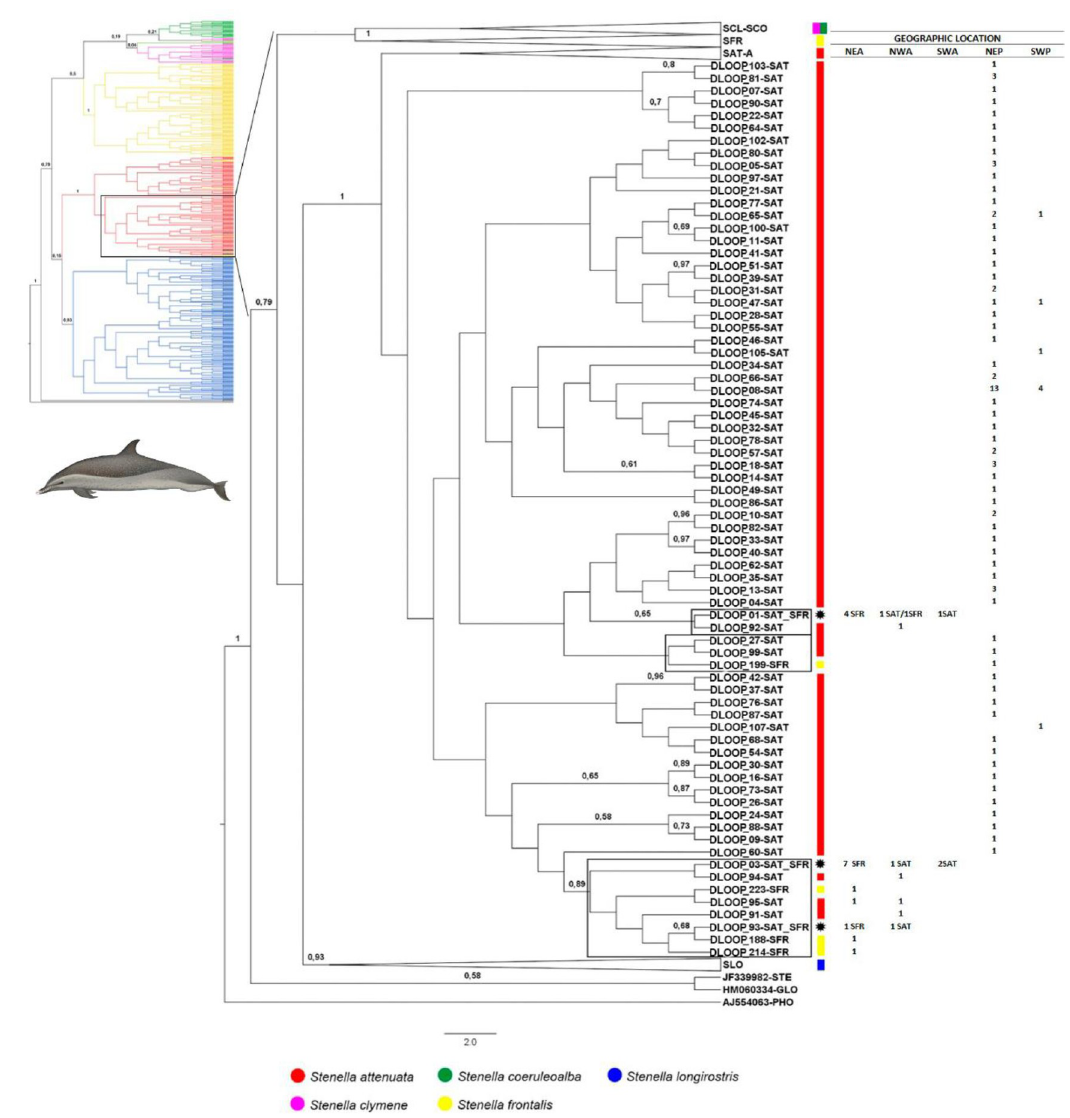
Fig 7. Bayesian cladogram generated in Beast from the Dloop sequences (331bp) highlighting the second clade of Stenella attenuata for ocean basin comparisons. Posterior probability values greater than 0.5 are presented above nodes. Black boxes indicate misplaced haplotypes. Table at right displays the ocean basin location of each haplotype and the number of specimens: NEA (Northeast Atlantic Ocean), NWA (Northwest Atlantic Ocean), SWA (Southwest Atlantic Ocean), NEP (Northeast Pacific Ocean), SWP (Southwest Pacific Ocean). The numbers in the columns represent the number of specimens for each haplotype. Dolphins images have been extracted from the website http://cis.whoi.edu/science/B/whalesounds/index.cf.